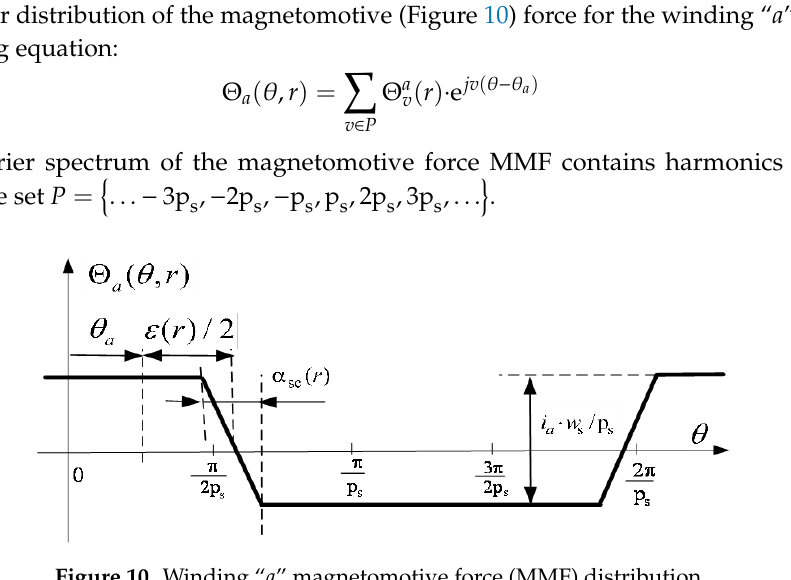
Figure 10. Winding “ a ” magnetomotive force (MMF) distribution.